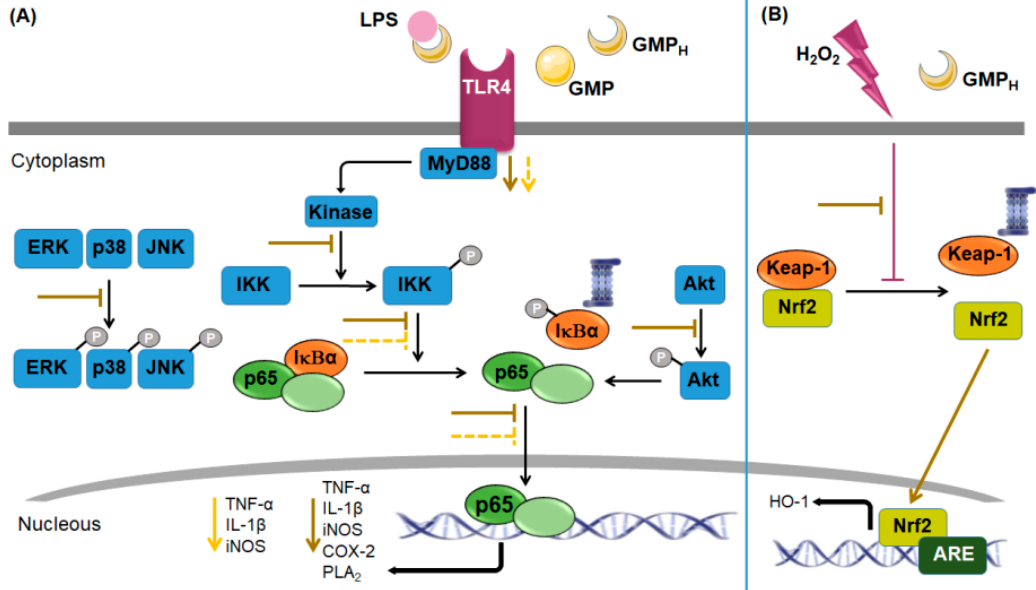
Figure 6. Signaling pathway involved in intact or papain-hydrolyzed glycomacropeptide modulation Signaling pathway involved in intact or papain-hydrolyzed glycomacropeptide on RAW 264.7 macrophage response to lipopolysaccharide or hydrogen peroxide. ( A ) modulation on RAW 264.7 macrophage response to lipopolysaccharide or hydrogen peroxide. Glycomacropeptide (GMP) and a papain-hydrolyzed GMP (GMP H ) downregulate pro-inflammatory ( A ) Glycomacropeptide (GMP) and a papain-hydrolyzed GMP (GMP H ) response of RAW 264.7 macrophages induced by lipopolysaccharide (LPS). GMP H is able to bind LPS and to suppress LPS binding to the macrophage surface. GMP H diminishes the increase in myeloid differentiation primary response protein (MyD88) messenger RNA (mRNA) expression levels, inhibits phosphorylation and degradation of inhibitor of κ B α (I κ B α ) and phosphorylation of kinase of I κ B α / β (IKK α / β ), and blocks p65 nuclear translocation in part by suppressing protein kinase B (Akt) phosphorylation. Additionally, it inhibits the phosphorylation of p-38, extracellular-signal- regulated protein kinase (ERK), and c-Jun N-terminal kinase (JNK) induced by LPS. GMP decreases MyD88 mRNA expression levels, p65 nuclear translocation, and phosphorylation and degradation of I κ B α . Discontinuous lines indicate a minor effect. ( B ) GMP H has antioxidant activity on hydrogen peroxide (H 2 O 2 )-stressed macrophages RAW 264.7. GMP H blocks the inhibition of nuclear translocation of the nuclear factor erythroid 2-related factor 2 (Nrf2) induced by H 2 O 2 , and, as a